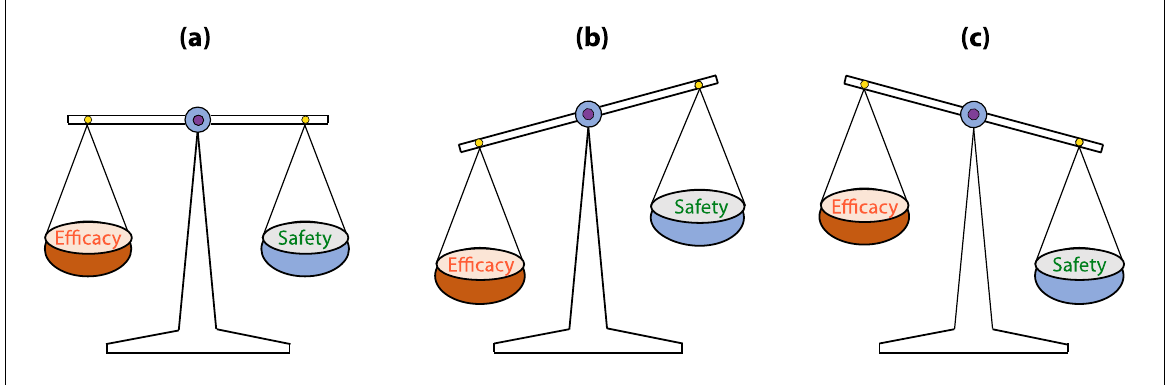
Figure 5. The efficacy and safety of CAR T-cell therapy in the treatment of solid tumors are always at opposite ends of the scale. ( a ) the balance between safety and efficacy, ( b ) higher safety, lower efficacy: safety improves always at the expense of efficacy, ( c ) higher efficacy, lower safety, efficacy improves always at the expense of